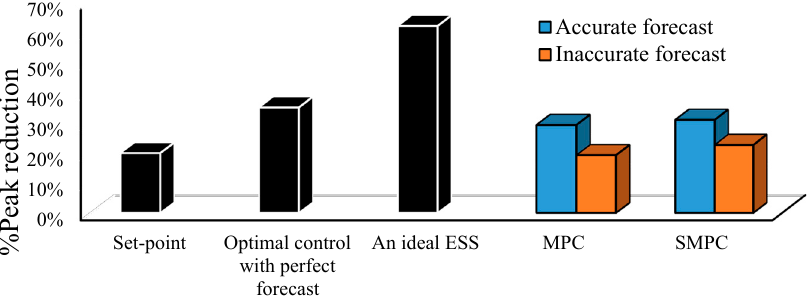
Figure 6. The average percentage of peak reduction for a specific case study.